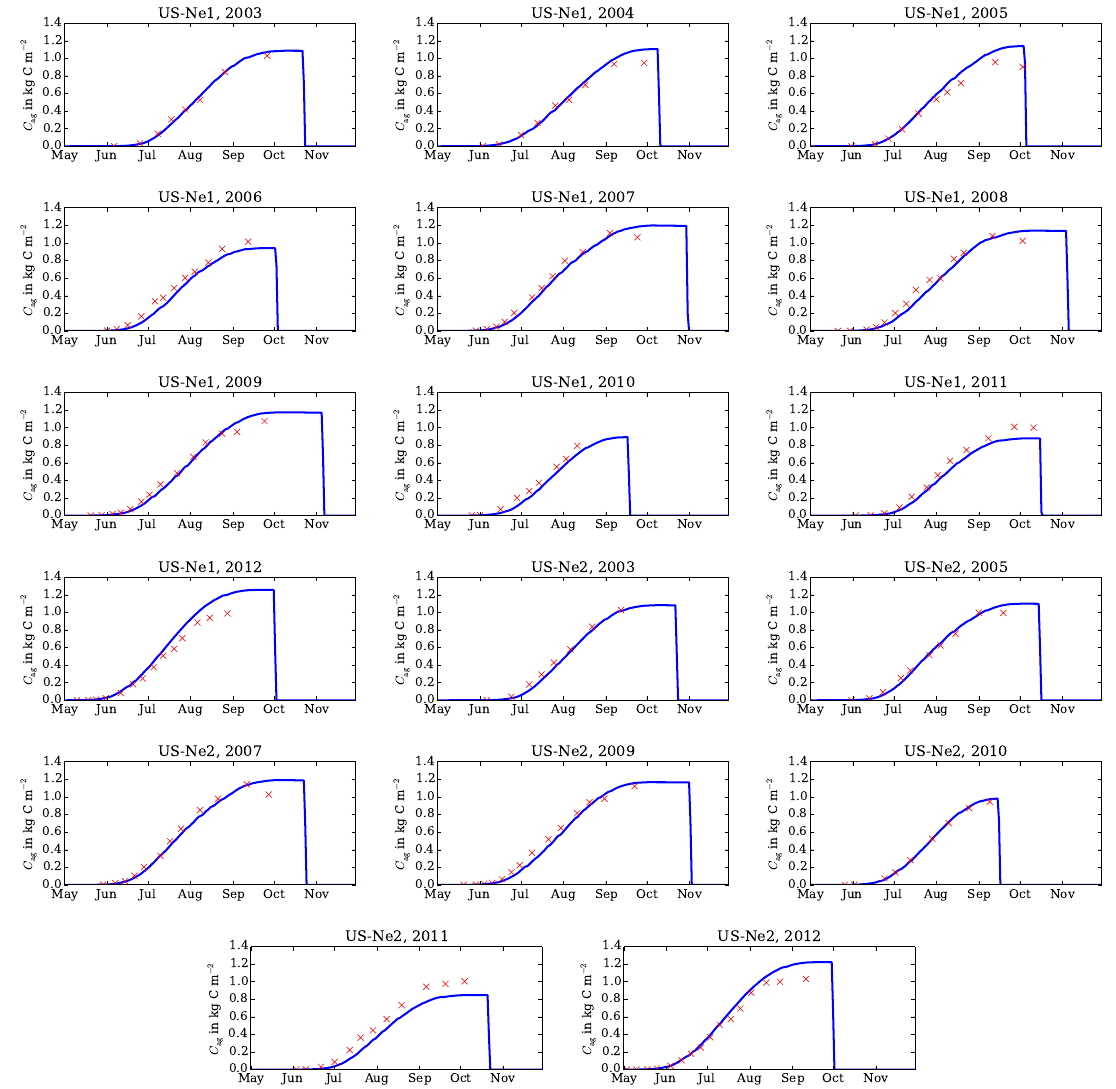
Figure 26. Time series for above-ground carbon for irrigated maize at the Mead FLUXNET sites US-Ne1 and US-Ne2; blue: model; red: observations. JULES runs have the crop model switched on and the input parameters in Tables 1, 2, 3, and 4.